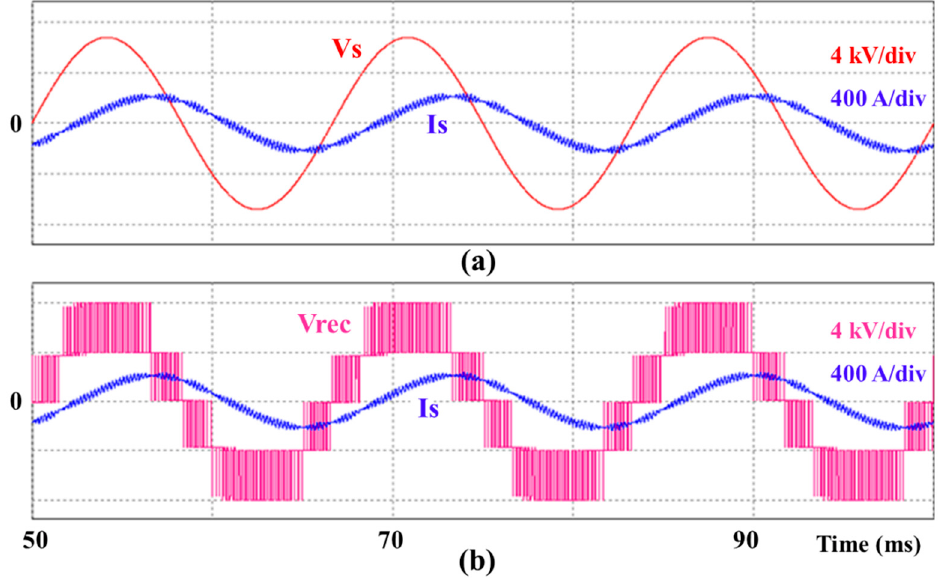
Figure 12. Simulation results for the five-level OCC MV Regen-Load waveforms with RL load. ( a ) Input voltage and input current; ( b ) Rectifier voltage and input